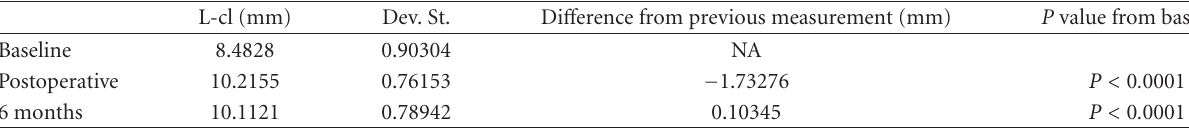
Table 2: Values of clinical crown length (L-cl) at tooth level.